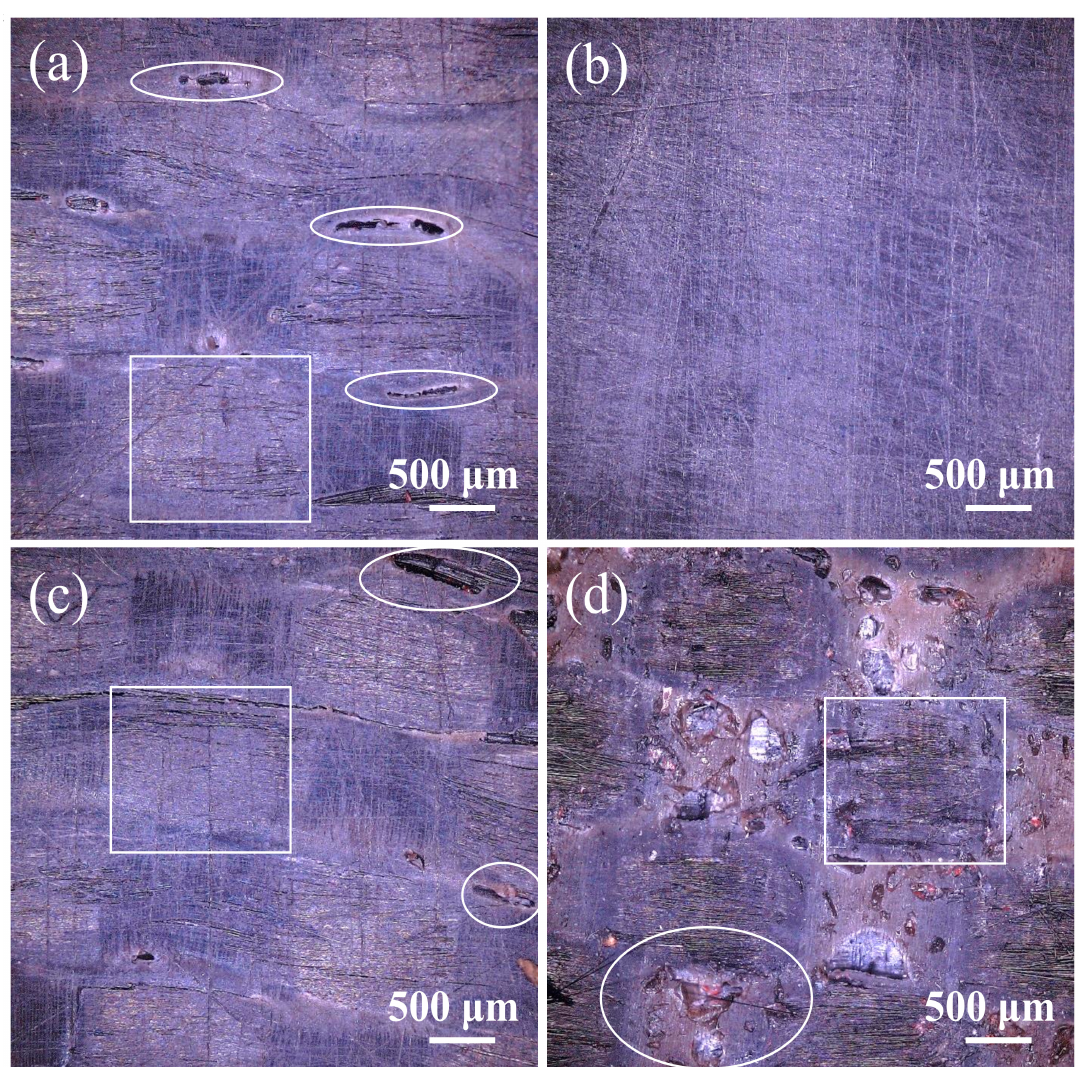
Figure 5. Surface morphology of CF/PEEK directional plates under different molding pressures: ( a ) 0.3 MPa; ( b ) 0.5 MPa; ( c ) 0.7 MPa; ( d ) 1.0 MPa.